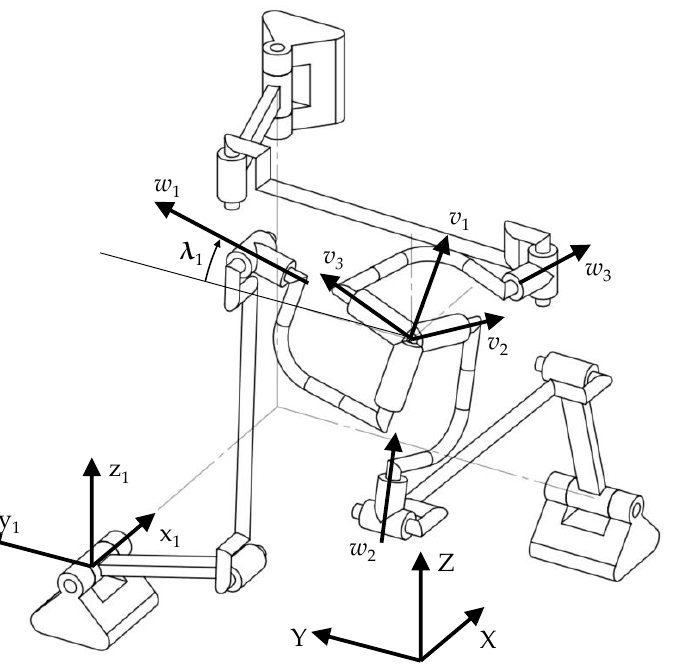
Figure 5. Slave mechanism in an arbitrary pose.